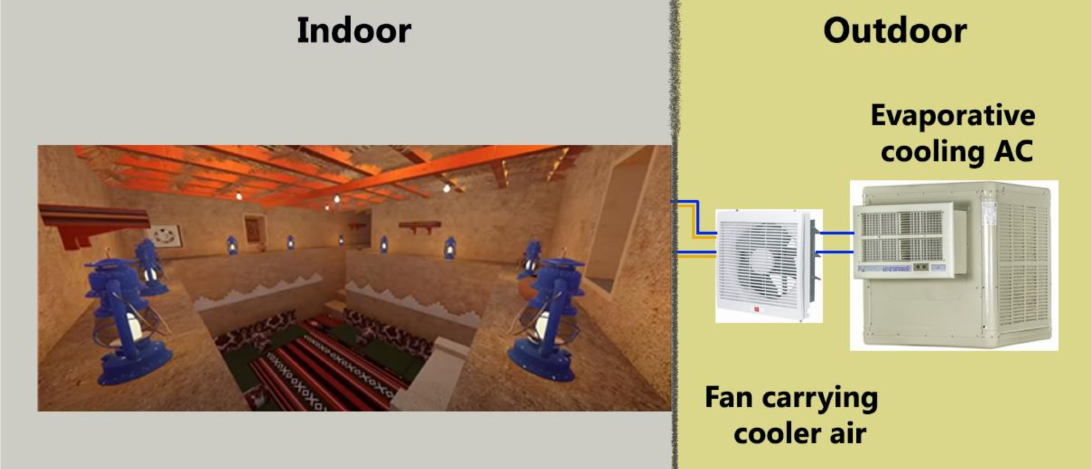
Figure 3. System design of evaporative cooling unit.